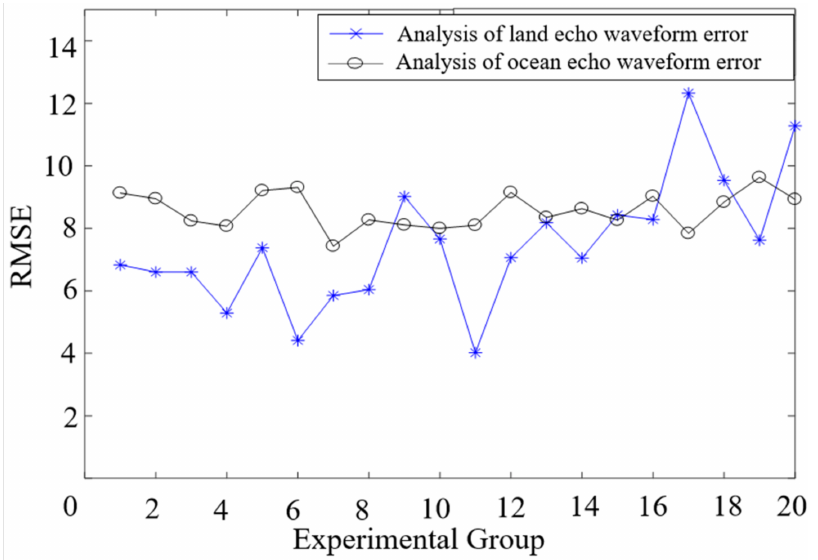
Figure 16. Error analysis of echo